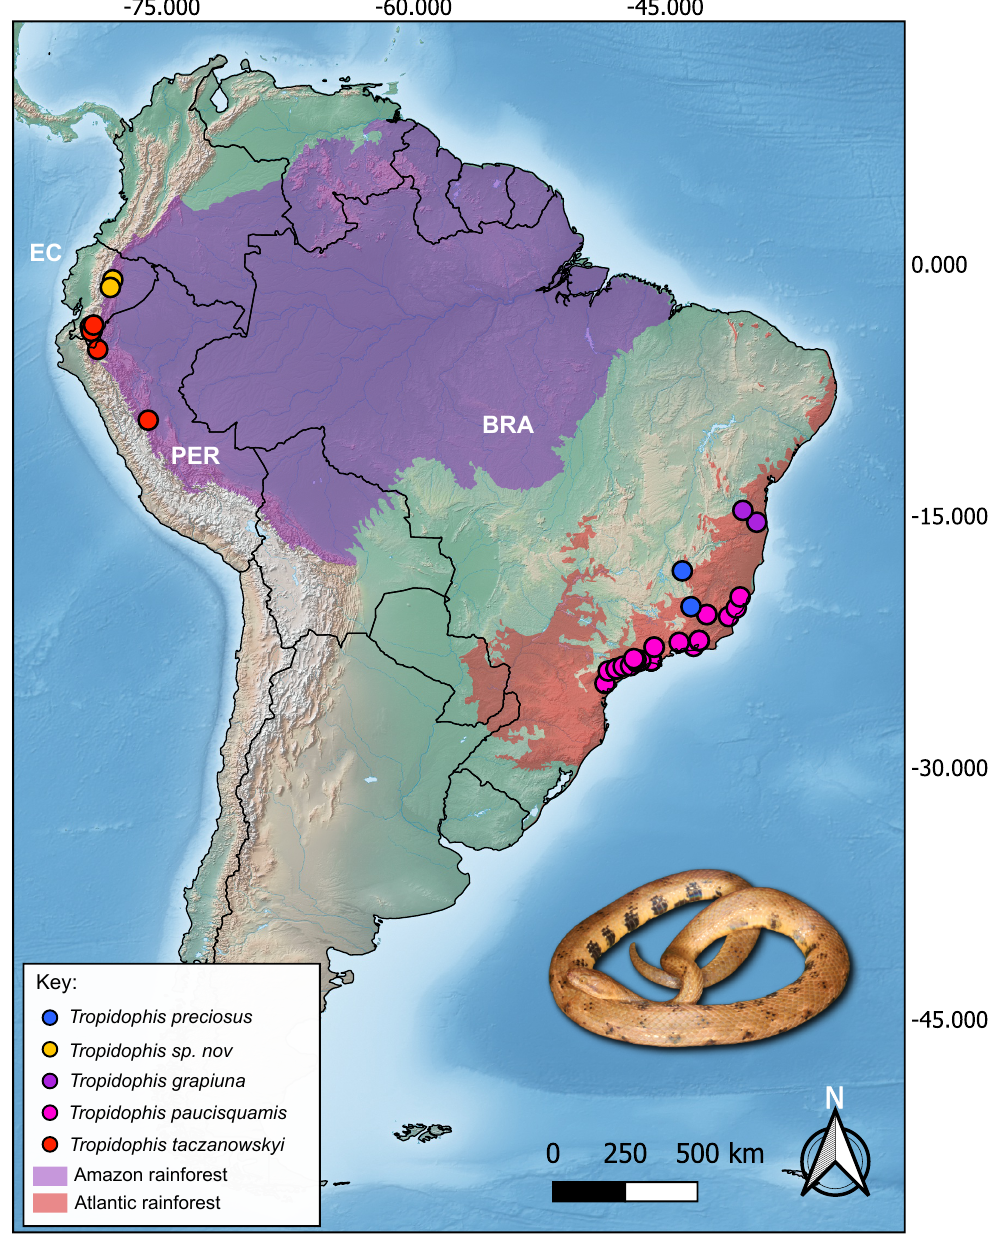
Fig. 1. Geographic distribution of mainland species of Tropidophis Bibron, 1840 in South America. Note the disjunct distribution pattern, with two allopatric groups: Andes mountain range (